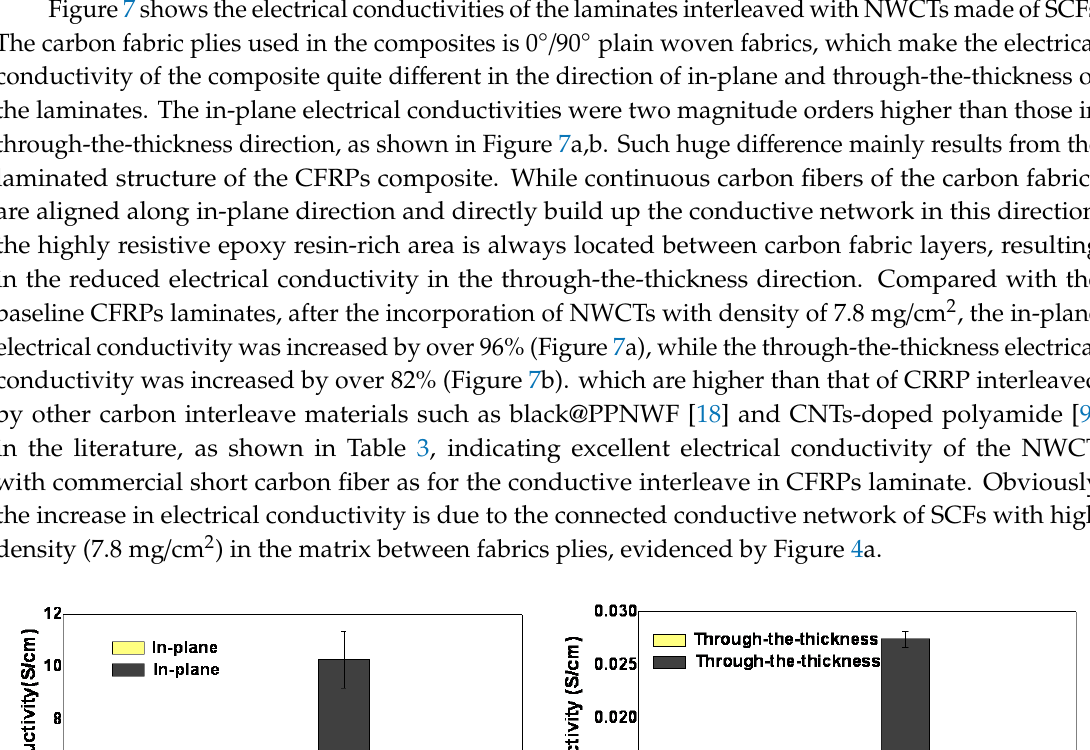
Figure 6. ( a )Flexural modulus and ( b ) flexural strength of NWCT reinforced laminate .